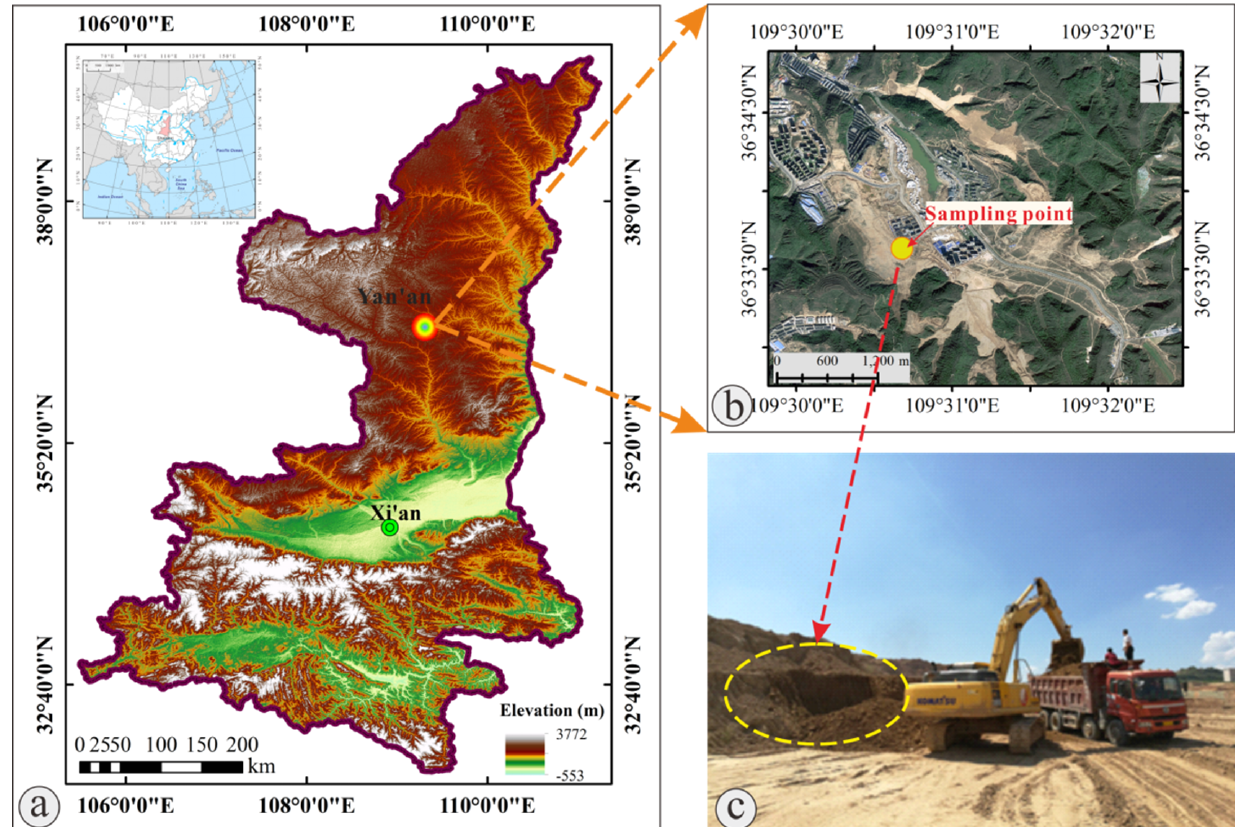
Figure 3. Location map of sampling points. ( a ) Sampling site, Shanxi Province; ( b ) loess fill in Qilipu community, Yan’an; ( c ) soil samples for